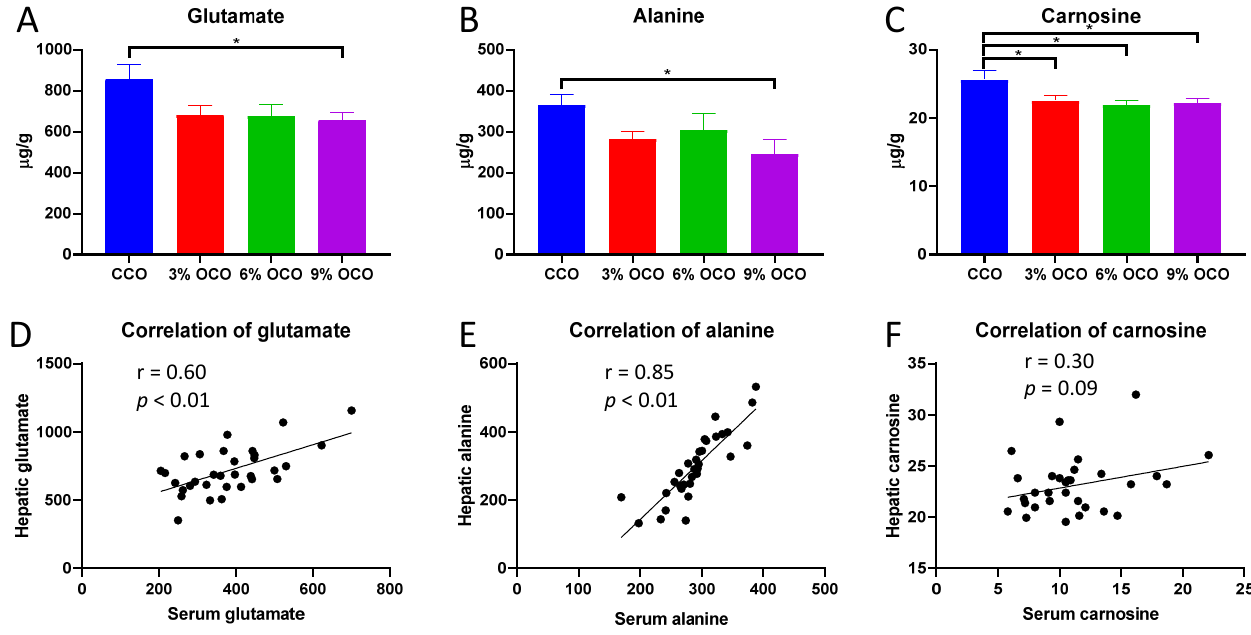
Figure 2 . Concentrations of oxidized corn oil (OCO)-responsive amino acids in the liver and their correlations with serum concentrations. Hepatic concentrations of glutamate ( A ), alanine ( B ), and carnosine ( C ). Value = mean ± SEM (n = 8 pigs/group). * p < 0.05 from one-way ANOVA followed by the Tukey post hoc test between control corn oil (CCO) and OCO treatments. The correlations between hepatic and serum concentrations of glutamate ( D ), alanine ( E ), and carnosine ( F ) and their significances were calculated by Pearson correlation analysis.